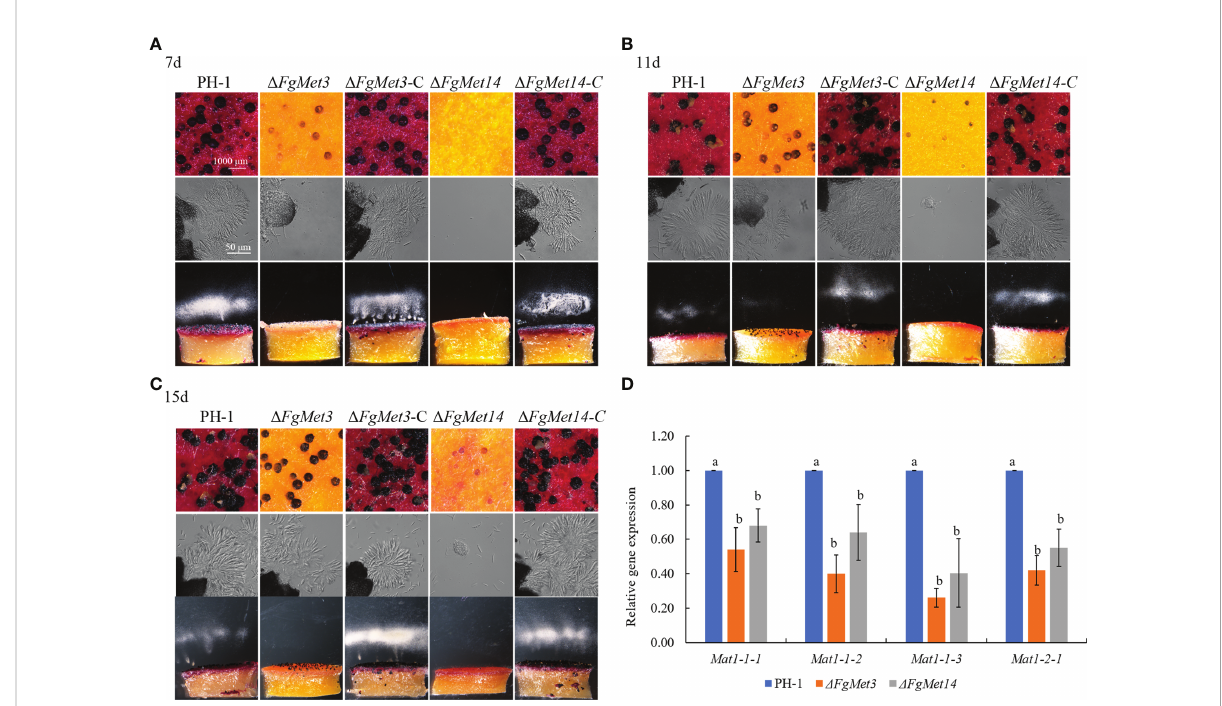
FIGURE 7 Sexual reproduction of PH-1, FgMet3 or FgMet14 deletion mutants and their complements. (A) The sexual reproduction of strains when incubated on carrot medium for 7 days. (B) The sexual reproduction of strains when incubated on carrot medium for 11 days. (C) The sexual reproduction of strains when incubated on carrot medium for 15 days. (D) Relative expression levels of sexual reproduction-related genes Mat1- 1-1, Mat1-1-2, Mat1-1-3, and Mat1-2-1 in the D FgMet3 and D FgMet14 mutants compared with the WT strain. Bars with the same letter indicate no signi fi cant difference according to the least signi fi cant difference (LSD) test. P =